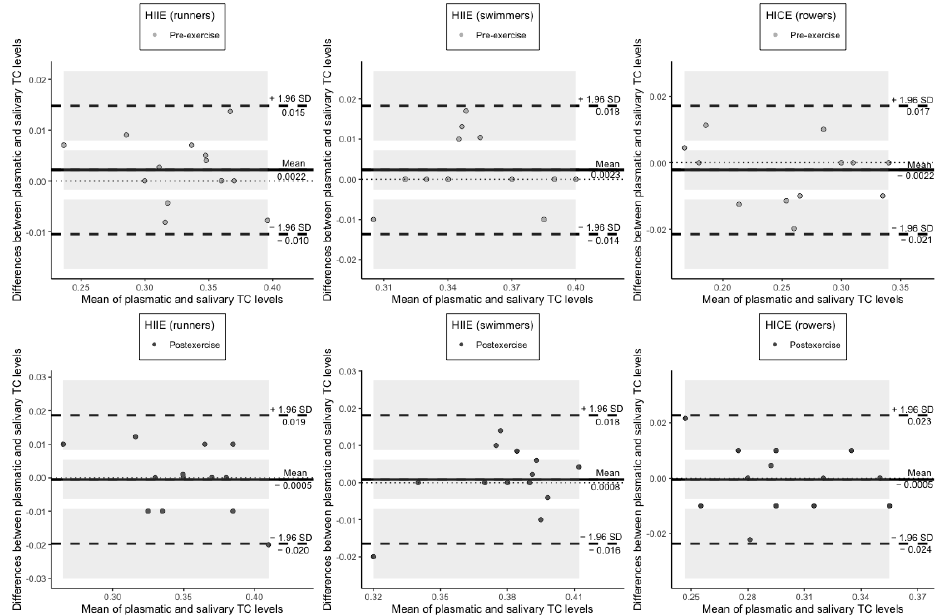
Figure 4. Plots of difference between the measurements of TC levels in plasma and saliva vs. the mean of the measurement. The bias (mean difference) is represented by a solid line parallel to the X axis. The limits of agreement are represented by the dashed lines parallel to the X axis at −1 .96 and +1.96 SD. Shaded areas present confidence interval limits for mean and agreement limits. TC: triene conjugates; HIIE: high-intensity interval exercise; HICE: high-intensity continuous exercise; SD: standard deviation.